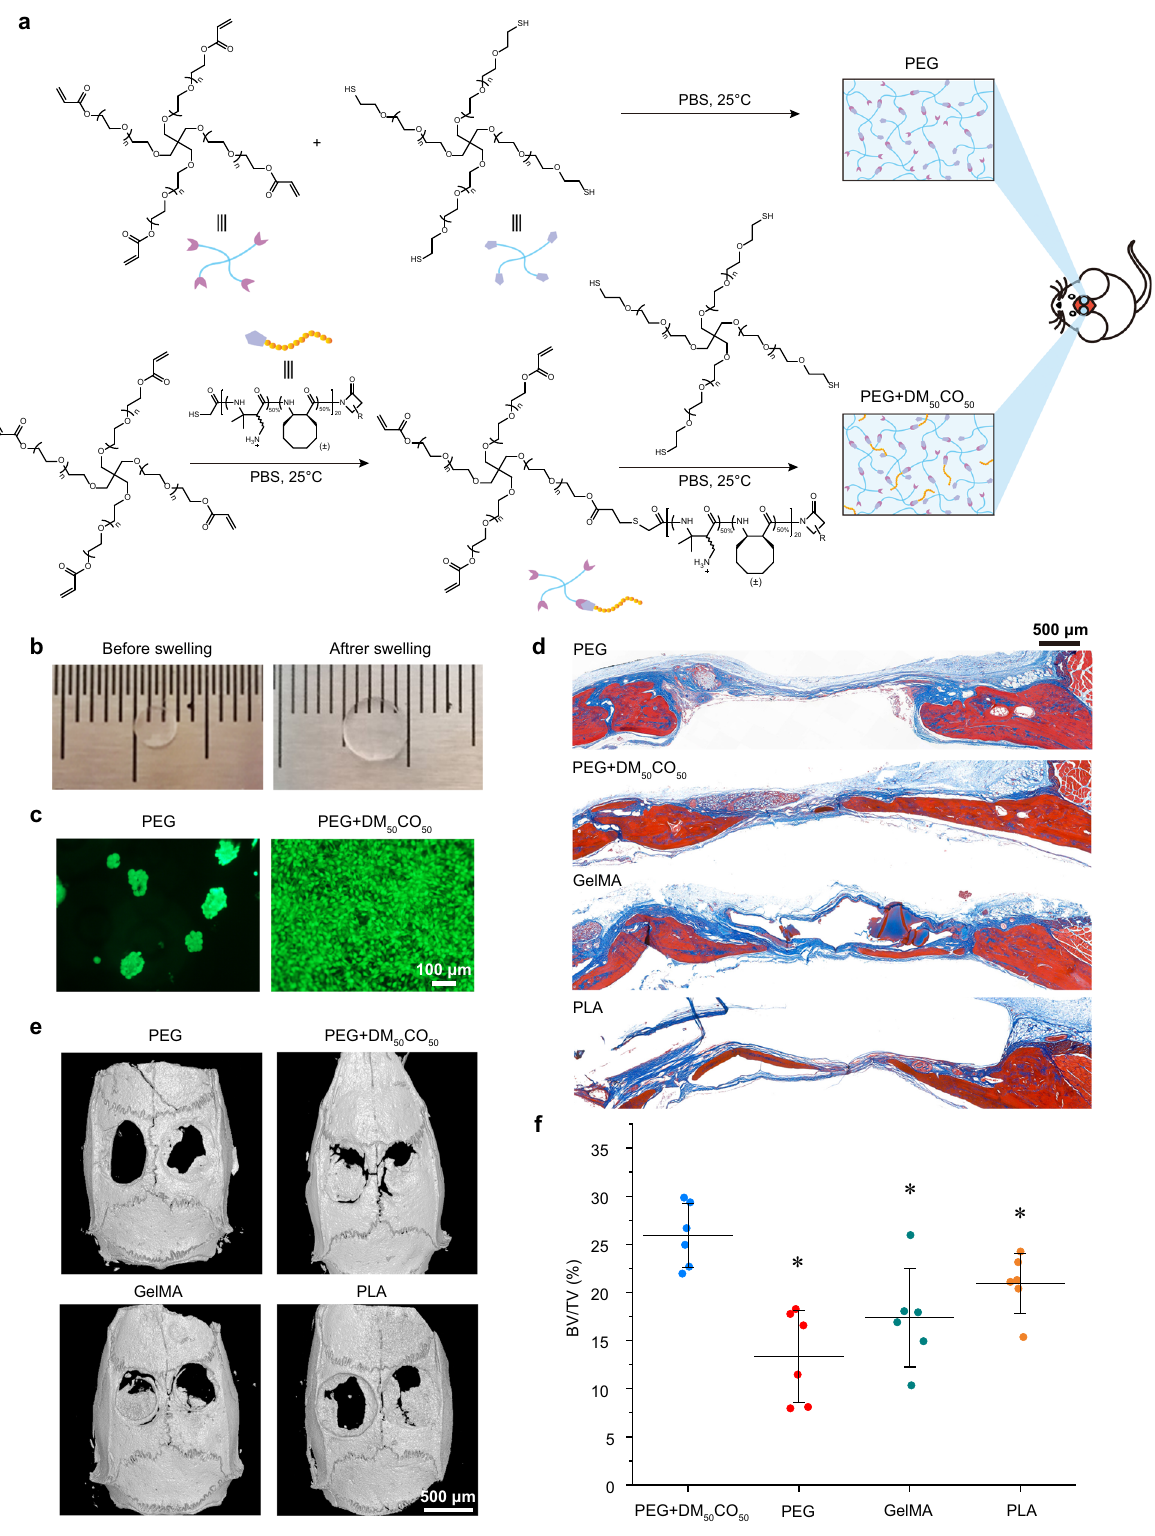
Fig. 7 Demonstration of cell adhesion impact of DM 50 CO 50 -incorporated hydrogel on in vivo bone regeneration using a critical-size rat calvarial defect model. a Synthesis of bare PEG hydrogel and DM 50 CO 50 -modi fi ed PEG hydrogel. b Comparison before and after PEG hydrogel swelling. c Preosteoblast cells adhesion to bare PEG hydrogel and DM 50 CO 50 -modi fi ed PEG hydrogel after cell seeding for 2 days. Cells were subjected to live/dead staining. d Masson ’ s trichrome stain, e 3D micro-CT analysis, and f bone volume analysis, of the cranial bone samples from bare PEG hydrogels, DM 50 CO 50 -modi fi ed PEG hydrogels, GelMA, and PLA after 8 weeks of implantation. Data in ( f ) represent mean ± s.d. ( n = 6). Statistical analysis: two-tailed t -test, * p <